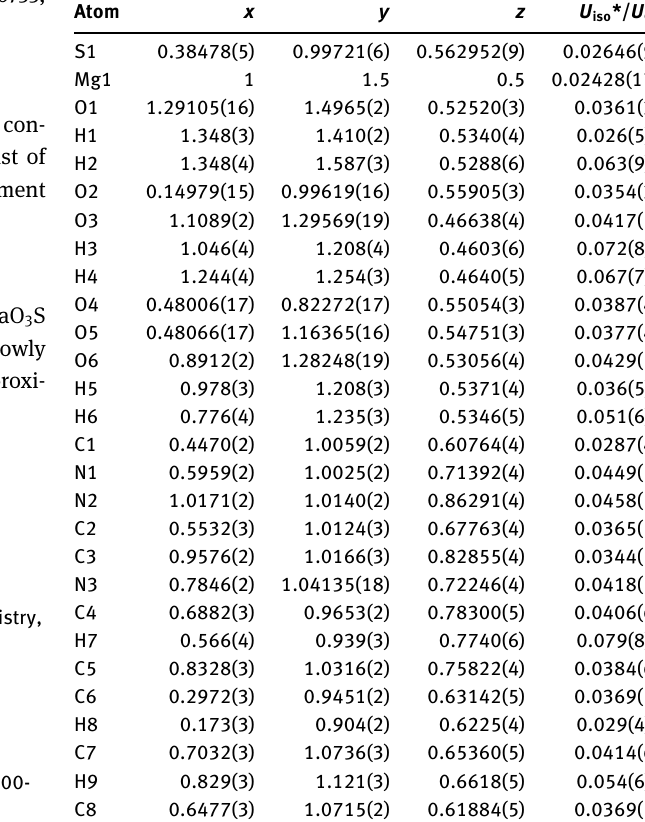
Table 2: Fractional atomic coordinates and isotropic or equivalent isotropic displacement parameters (Å 2